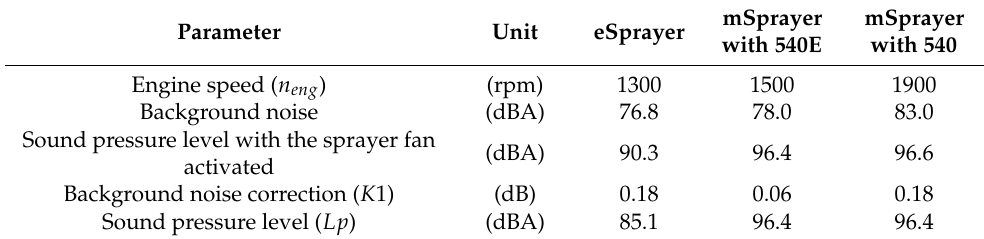
Table 8. Noise tests results with fan speed ( n f ) set at 1800 rpm.